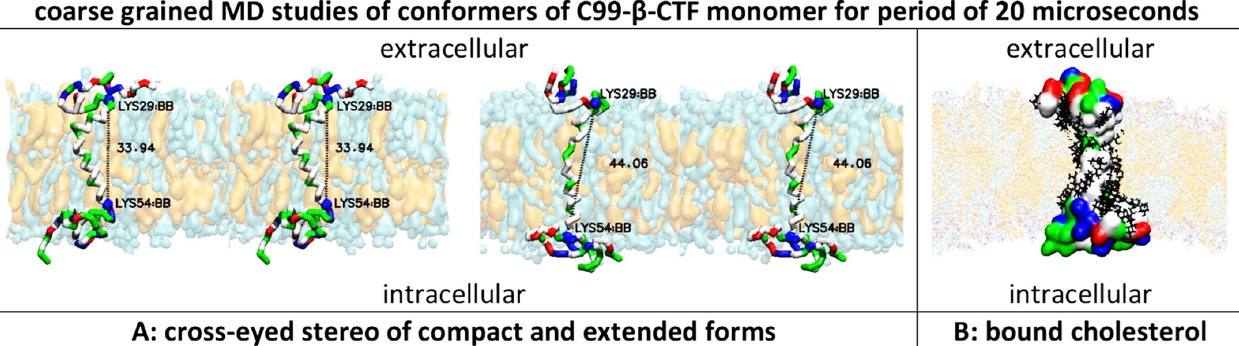
Figure 1. ( A,B ) Multiscale molecular dynamics studies of C99- β -CTF-APP’s structure in a cholesterol–lipid bilayer: Multiscale MD calculations can provide dynamic structural depictions of C99- β -CTF-APP’s structure that can be related to previous studies [27,33,37,41,42] . The amino acids are shown as hydrophobic (white), positive (blue), negative (red), and polar non-charged (green). The cholesterol–lipid bilayer shows surface models of cholesterol (orange) in a mixture of POPC, POPA, POPE, POPS, POPI, and PSM molecules (cyan) (Methods). ( A ) The transmembrane section of the C99- β -CTF-APP backbone can exist in compact and extended forms [27] . The transmembrane helix is hydrophobic (white), with notable polar sites at Thr 43 and Thr 48 (green) and hinge sites at Gly38–Gly39 (green). Changes in Lys29–Lys54 distances (numeration as in PDB:2LP1) show that the shortest conformer is around 33.94 Å long, while the longest conformer is about 44.06 Å long. About 62% of the time, the protein takes conformations that are about 37.7 ± 2.5 Å long. The extracellular and intracellular parts are rich in positive (blue), negative (red), and polar (green) amino acids. The extracellular and intracellular structures represent a dynamic network of competing interaction between different amino acids and polar lipid heads (Supplementary Figure S1). ( B ) C99- β -CTF-APP’s Connolly surface shows that charged and polar amino acids in the ex- tracellular and intracellular domains form compact structures atop the lipid bilayer [27] . The sur- face of the hydrophobic transmembrane section can be covered (rigidified?) with cholesterol mol- ecules (black lines) [33] .